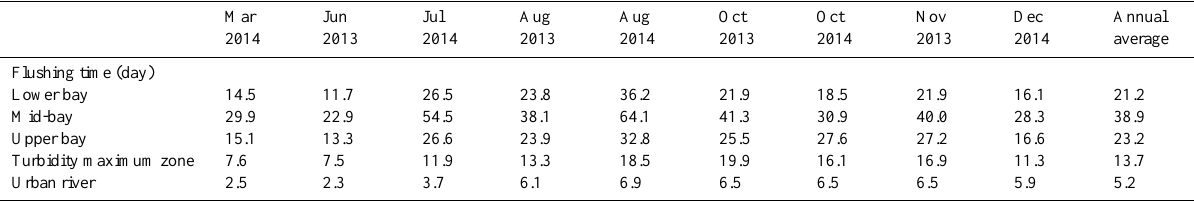
Table 3. Flushing time in five of the six zones in the Delaware Estuary during each